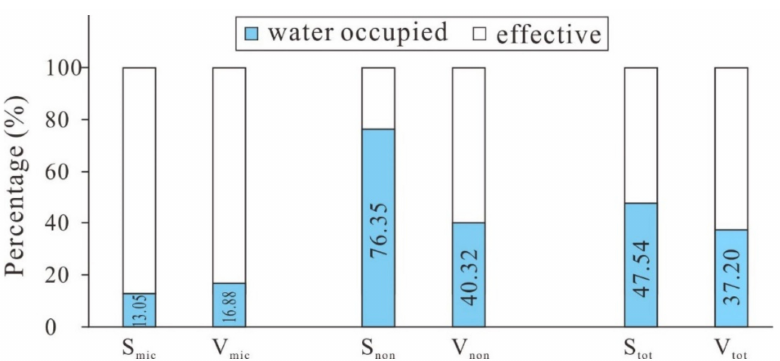
Figure 11. Average percentages of the water-occupied pore surfaces and volumes for the deep shales in the Luzhou Block.